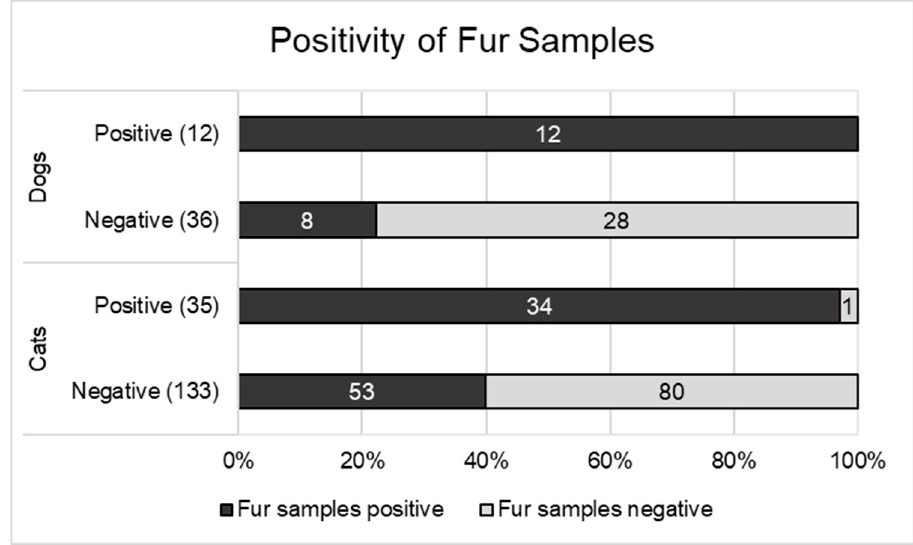
Figure 2. Distribution of positive fur samples for SARS-CoV-2-positive and SARS-CoV-2-negative dogs and cats.